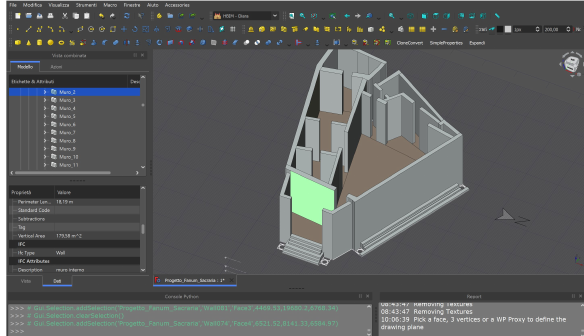
Figure 5 . Detail on parametric walls obtained by extruding 2D wires from the ground plan.